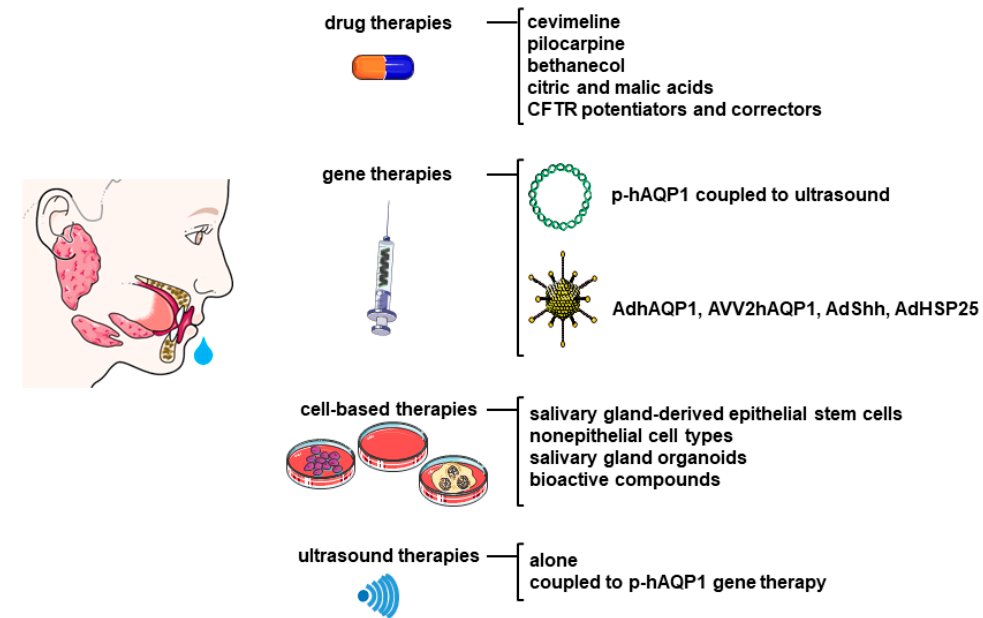
Figure 3. Role of AQPs in the treatment of xerostomia in SS patients. AAV2hAQP1: adeno-associated virus type 2 encoding hAQP1; AdhAQP1: adenovirus encoding hAQP1; AdShh: adenovirus encoding